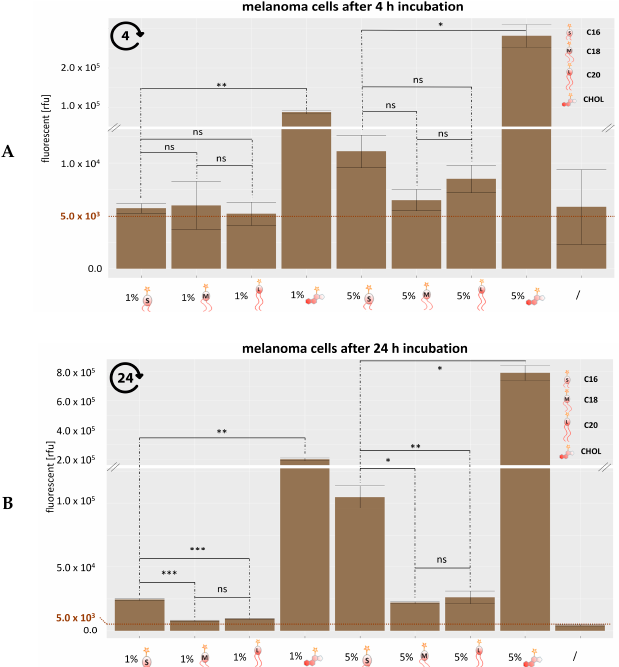
Figure 2. Quantification of lipid exchange after 4 h ( A ) and 24 h ( B ) by flow cytometry. 1.0 × 10 5 UKRV- Mel-15a cells were incubated with 1 or 5 vol-% atto 488 linked liposomes at 37 °C and fixed with a